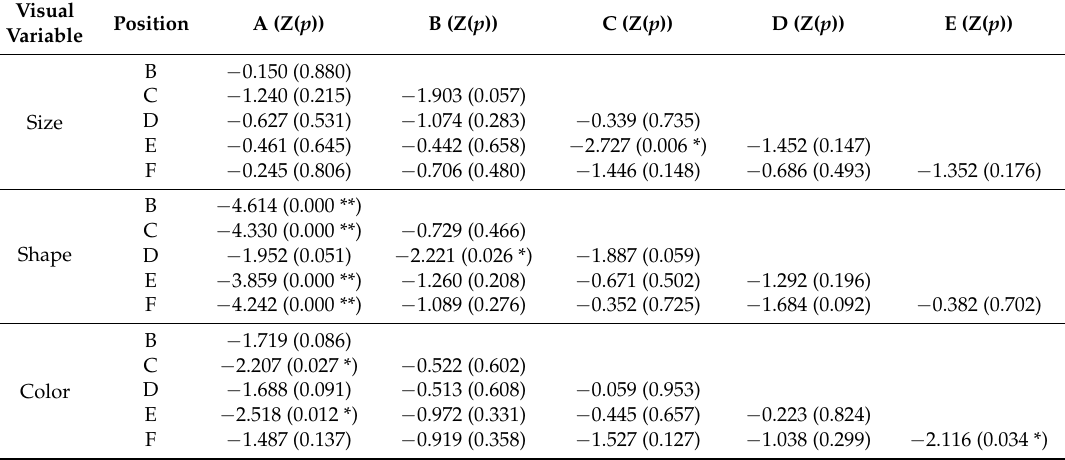
Table 3. AFD statistics and significance testing results for the constancy tasks (Exp.